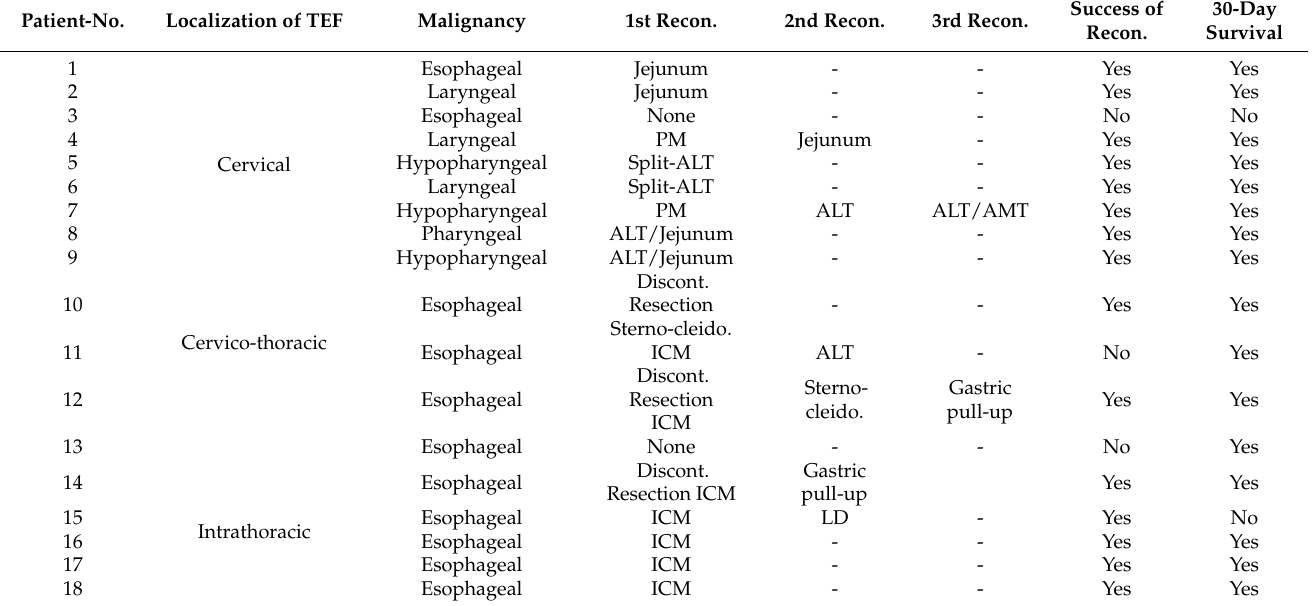
Table 2. Outcomes after reconstruction for TEF (ALT, anterolateral thigh flap; AMT, anteromedial thigh flap; sternocleido, sternocleidomastoid muscle flap; Discont. Resection, discontinuity resection of the esophagus; TEF, tracheoesophageal fistulae; ICM, intercostal muscle flap; Recon, reconstruction).